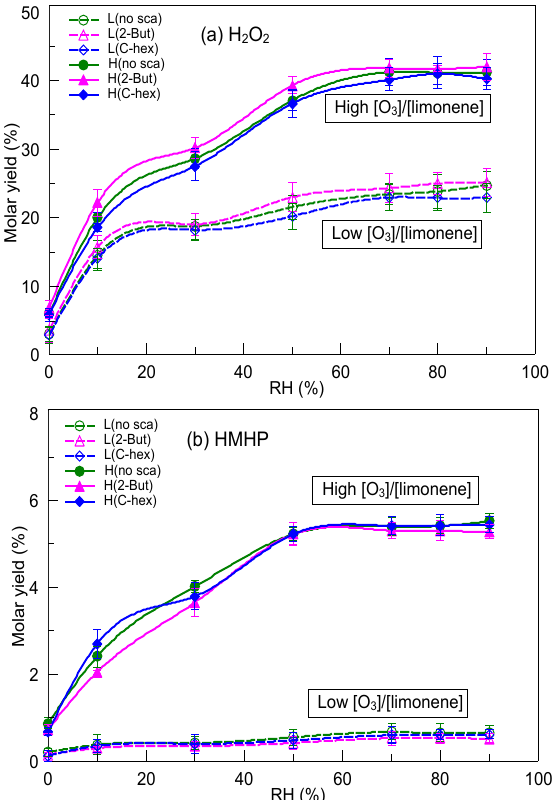
Figure 1. Dependence of (a) H 2 O 2 yield and (b) HMHP yield on relative humidity (RH) at a low or high [O 3 ] / [limonene] ratio in the presence or absence of the OH scavenger (2-butanol or cyclohex- ane). H 2 O 2 , hydrogen peroxide; HMHP, hydroxymethyl hydroper- oxide; L, low [O 3 ] / [limonene] ratio; H, high [O 3 ] / [limonene] ra- tio; No-sca, no scavenger; 2-But, 2-butanol; C-hex,